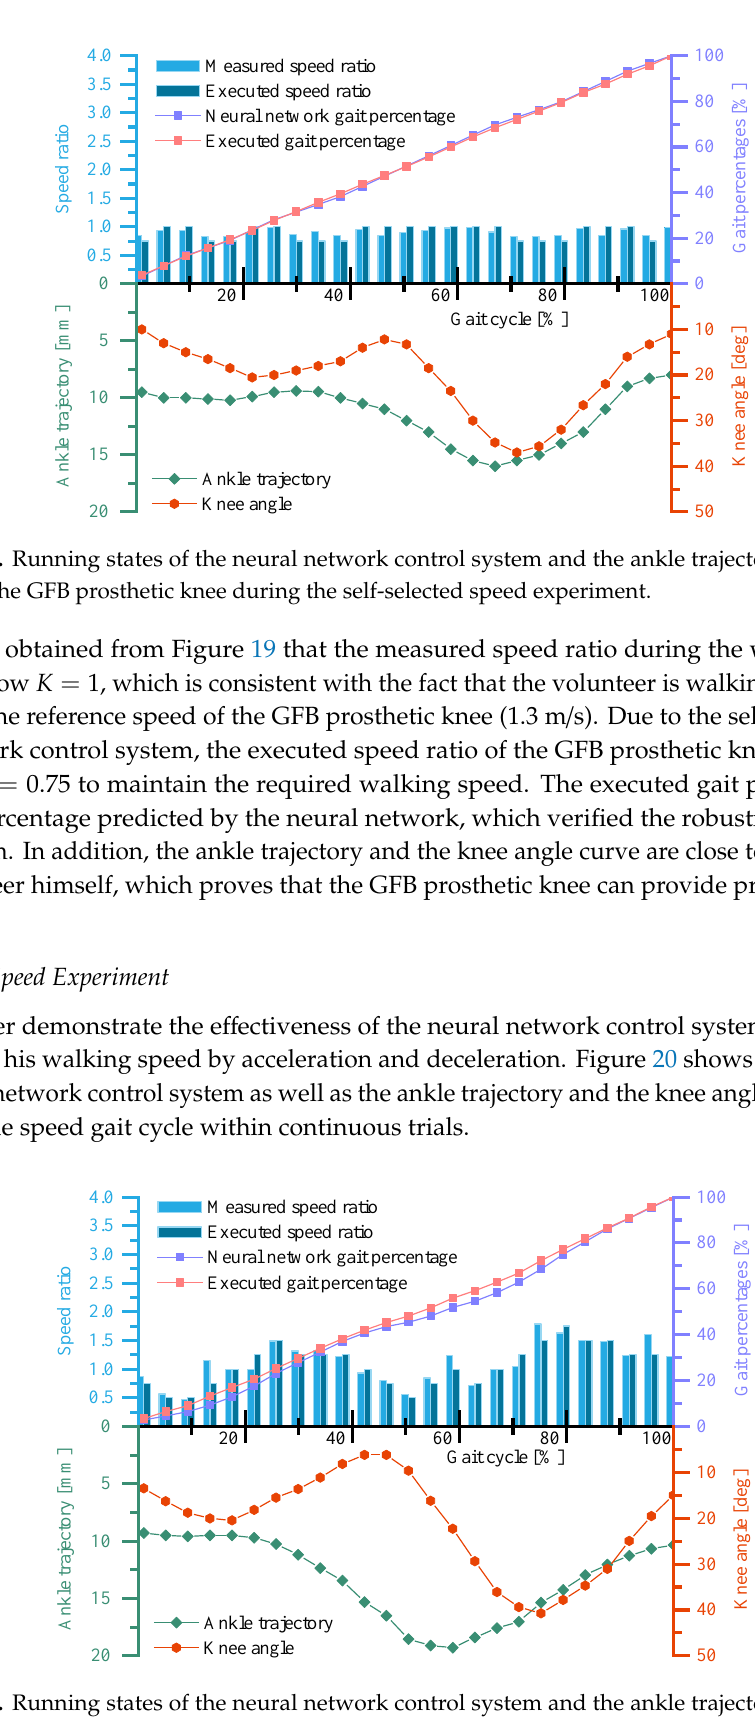
Figure 20. Running states of the neural network control system and the ankle trajectory/knee angle curve of the GFB prosthetic knee during the variable speed experiment.